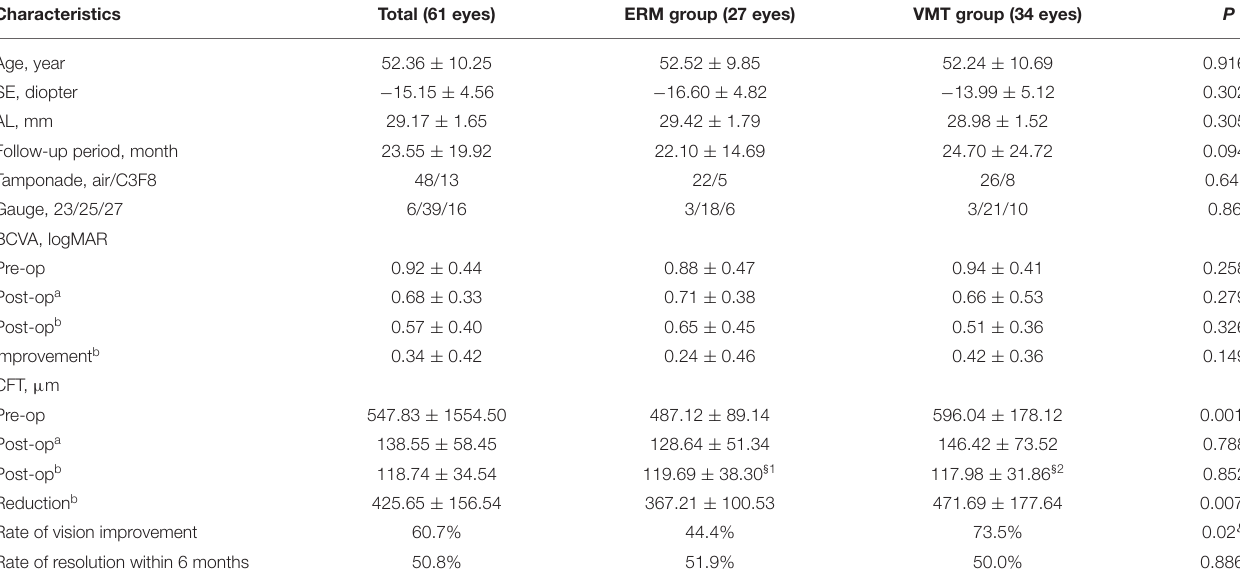
TABLE 3 | Comparation of demographic and surgical data between eyes with different pattern of vitreomacular interface abnormalities. Characteristics